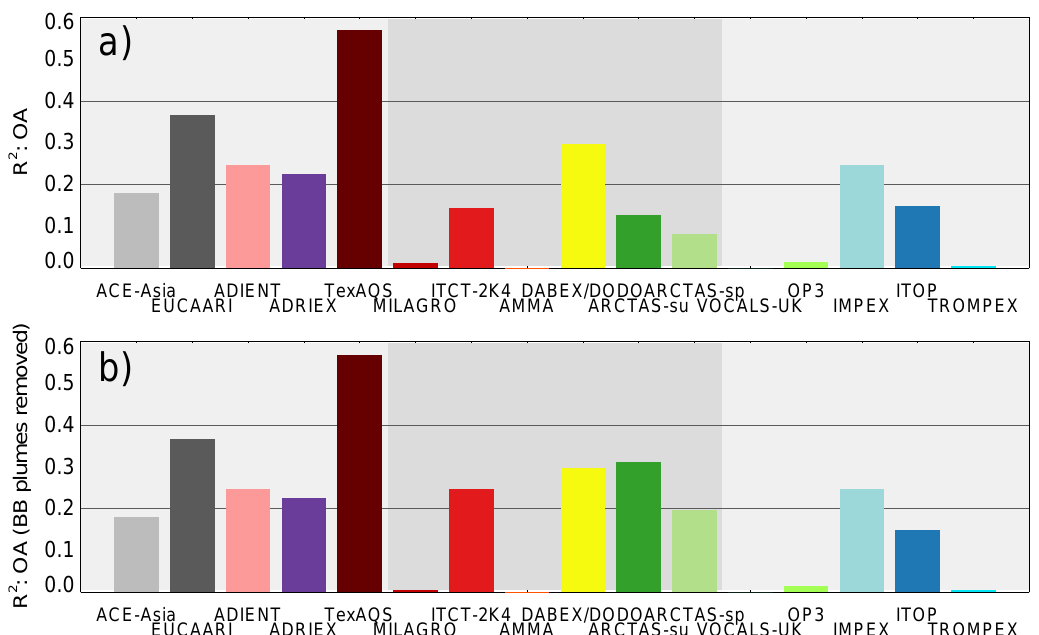
Fig. 7. Fraction of the observed variability reproduced by GEOS-Chem for each field campaign for (a) OA, (b) OA (with biomass burning plumes removed, see